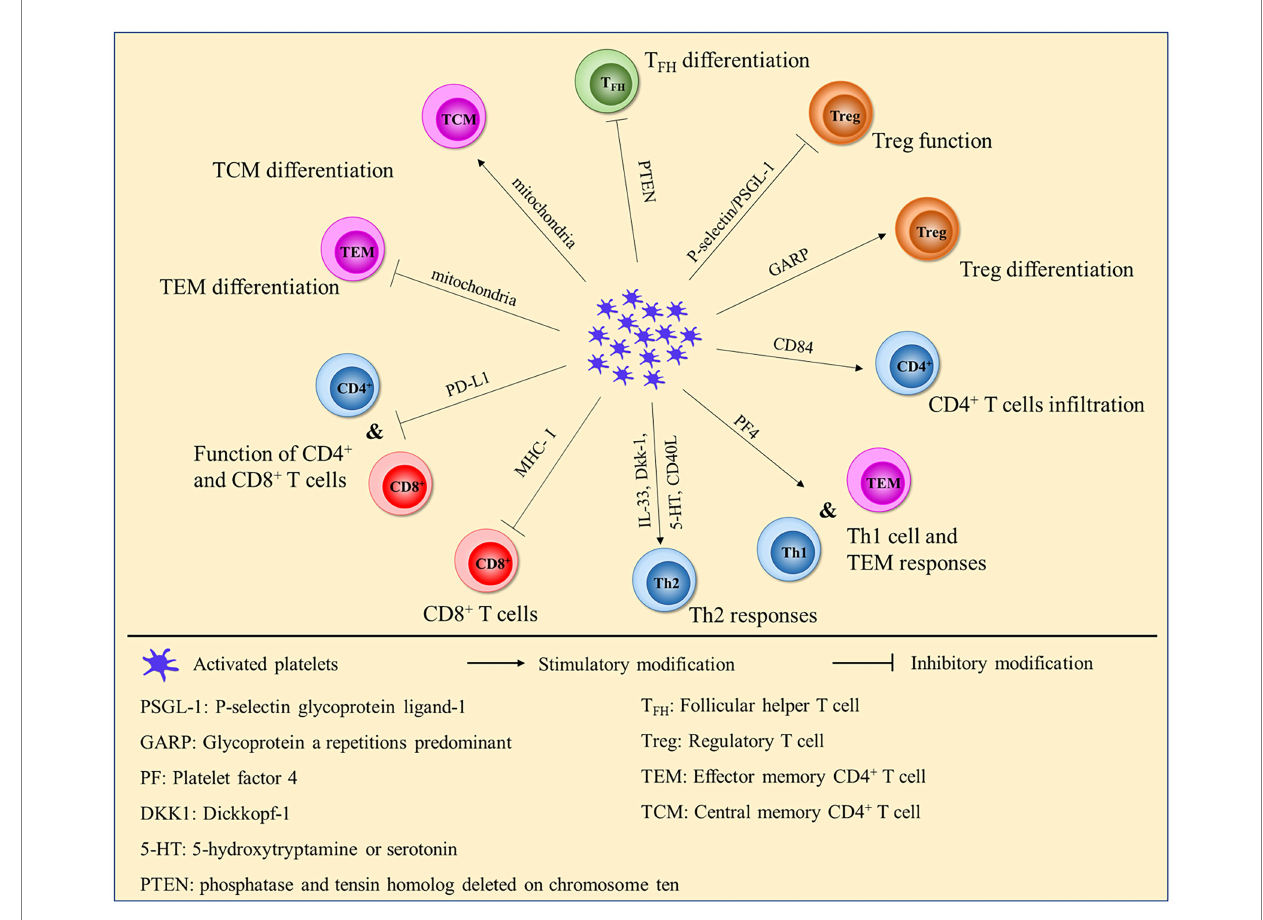
FIGURE 1 Platelets affect the function and differentiation of CD4 + and CD8 + T